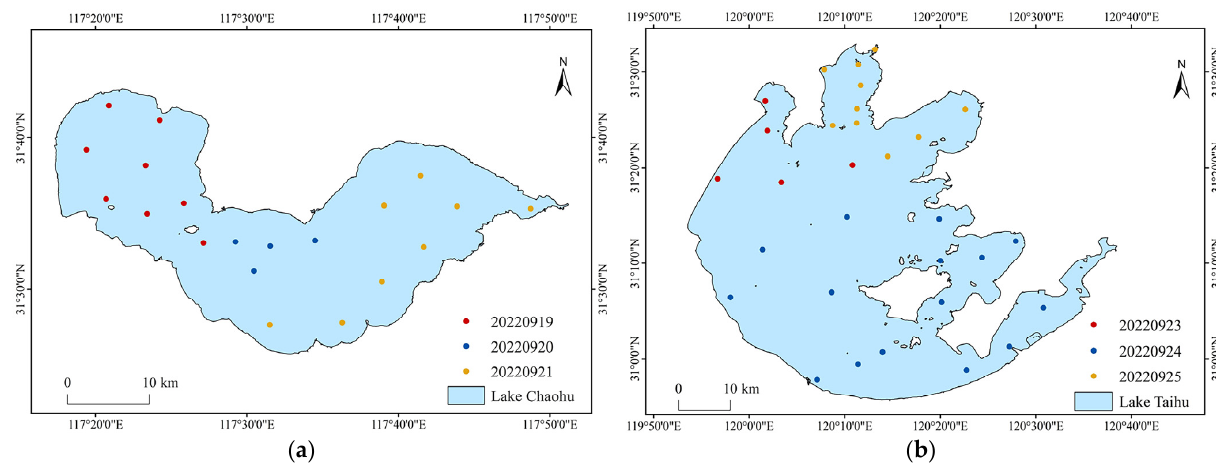
Figure 3. Study area and sampling locations ( a ) Chaohu ( b ) Taihu. Figure 4. Data collection flow.